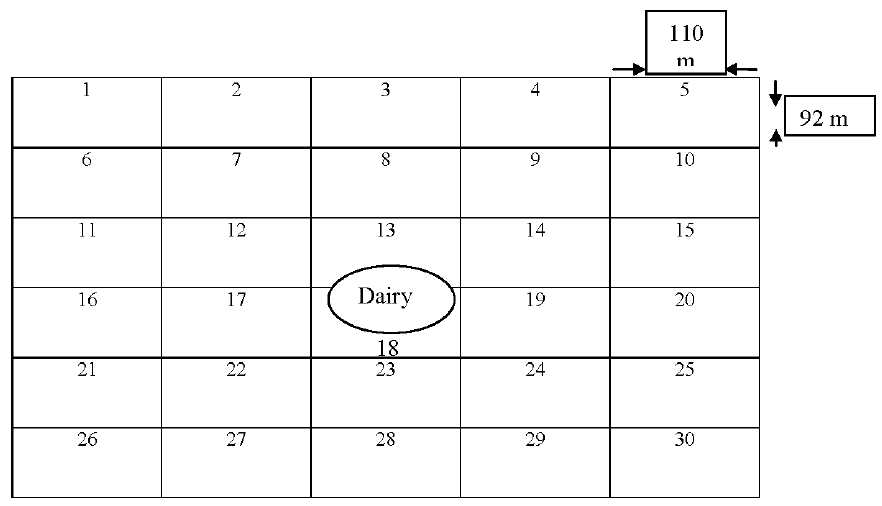
Figure 1. An example of 30 paddocks, each 1-ha farm structure for automatic milking system